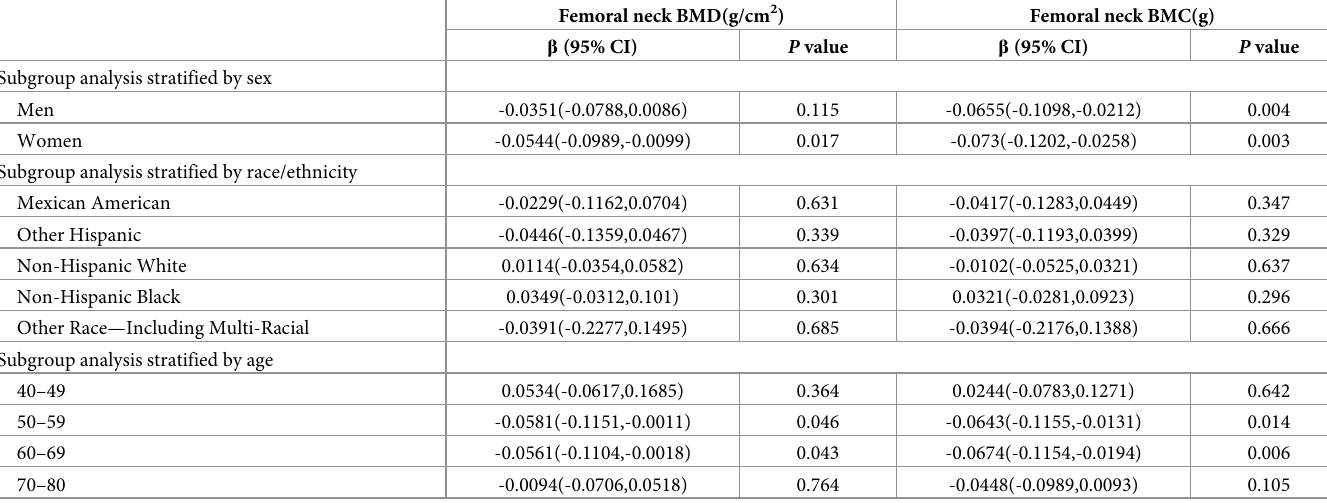
Table 4. Association of blood manganese with femoral neck BMD/BMC, stratified by sex, race/ethnicity and age.